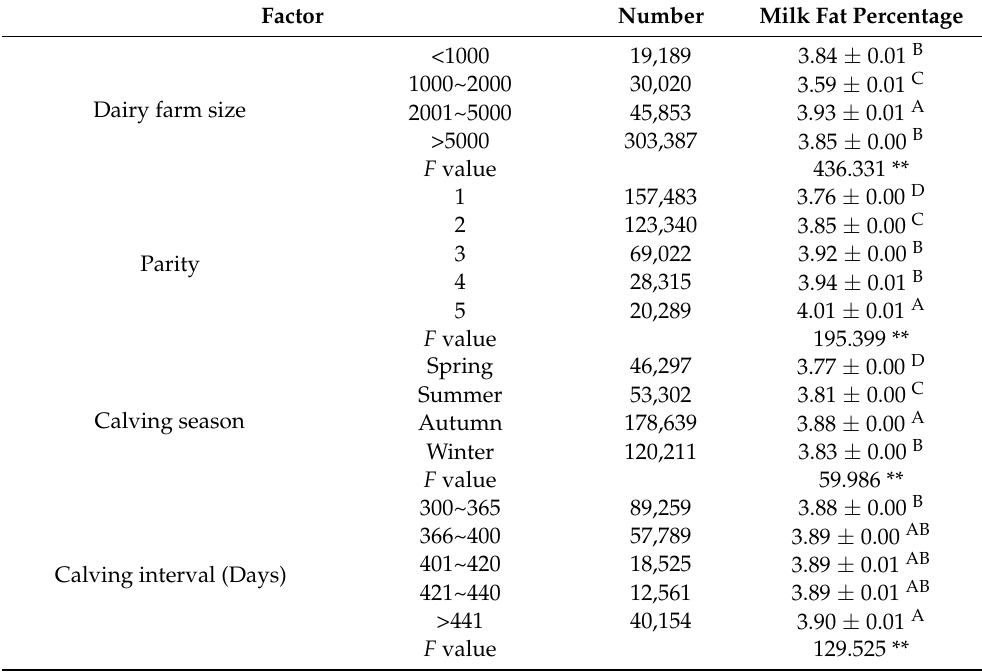
Table 3. Effects of different factors on milk fat percentage (LSM ±